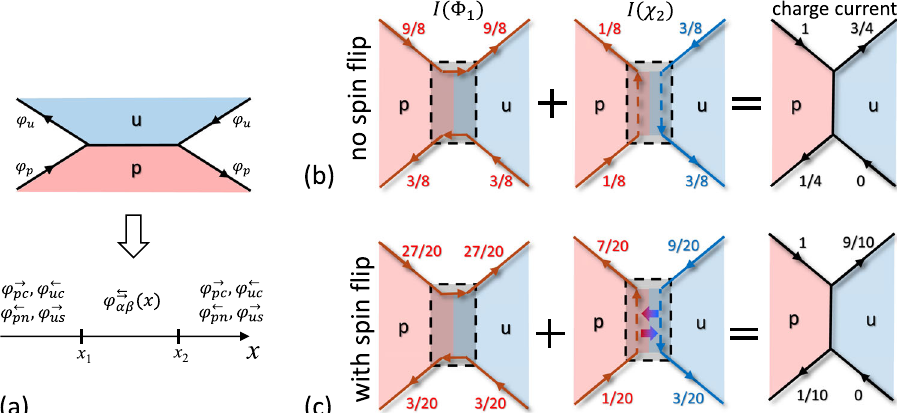
Fig. 3 Schematic representation of currents. a Mapping of bosonic modes φ α along sample edges onto a 1D Luttinger model modes φ $ αβ ð x Þ for a domain wall with length L = x 2 − x 1 . Subscripts α = { p , u } label polarized and unpolarized phases, β = { c , n , s } is for charge, neutral, and spin modes and an arrow in the superscript speci fi es projection of the mode ’ s group velocity. Arrows on the edges de fi ne the chirality of edge channels. b , c Visualization of currents due to the propagation of Φ 1 and χ 2 modes without spin fl ips ( b ) and in the presence of spin fl ips with the probability r = 3/4 ( c ). Red (blue) mode color indicates a spin-up (spin-down) polarization. Numbers indicate the fraction of the incoming current carried by the mode. Arrows correspond to directions of currents carried by corresponding